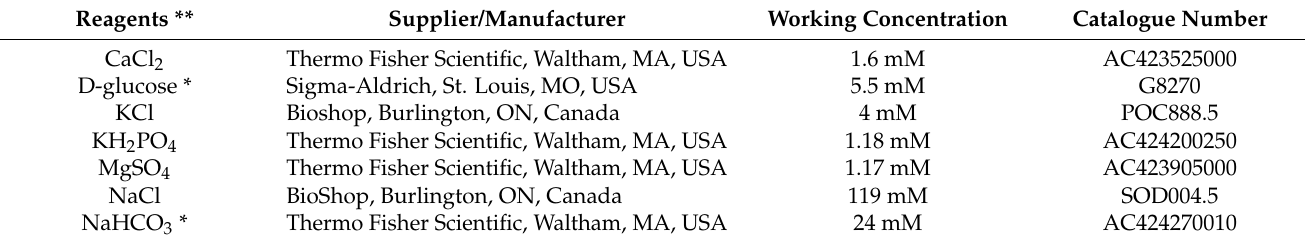
Table 10. Composition of aCSF